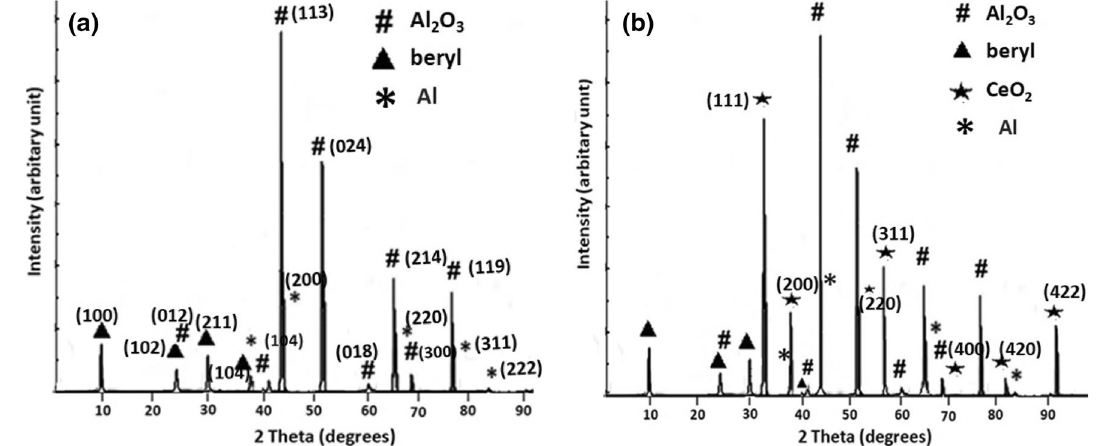
Fig. 2 XRD patterns of ( a ) “Al6061–9% Beryl” and ( b ) “Al6061–9% Beryl–0.5% CeO